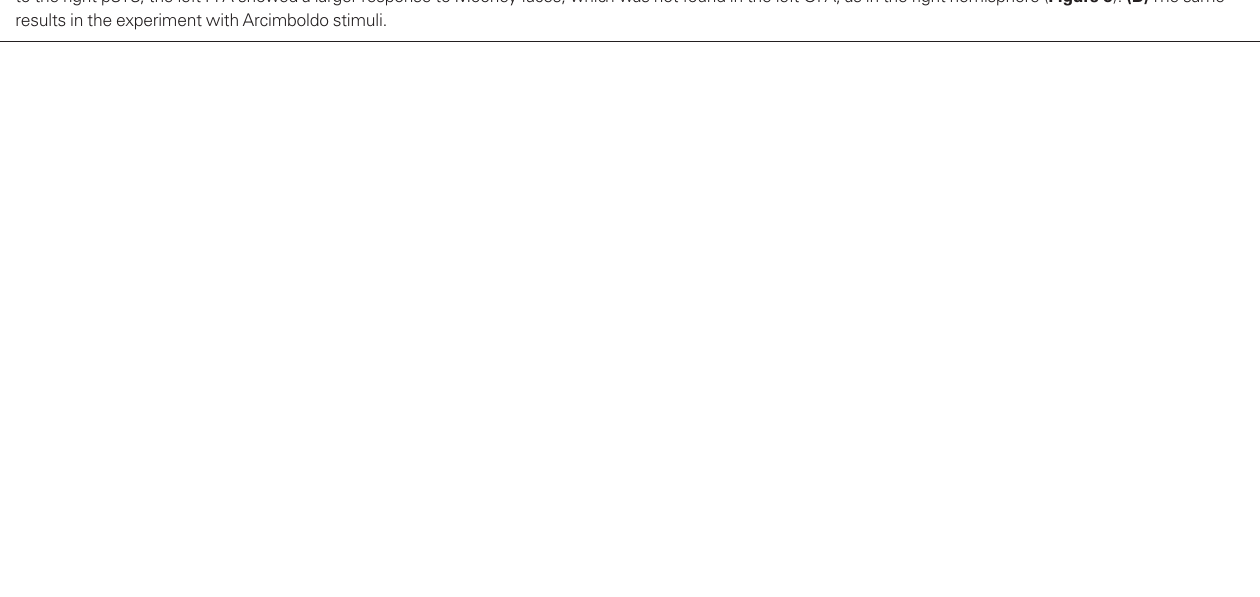
Figure A3 | (A) Time-course of activation in other face-sensitive regions for the group of normal participants in the Mooney face detection task. Note that in addition to the right pSTS, the left FFA showed a larger response to Mooney faces, which was not found in the left OFA, as in the right hemisphere ( Figure 5 ). (B) The same results in the experiment with Arcimboldo